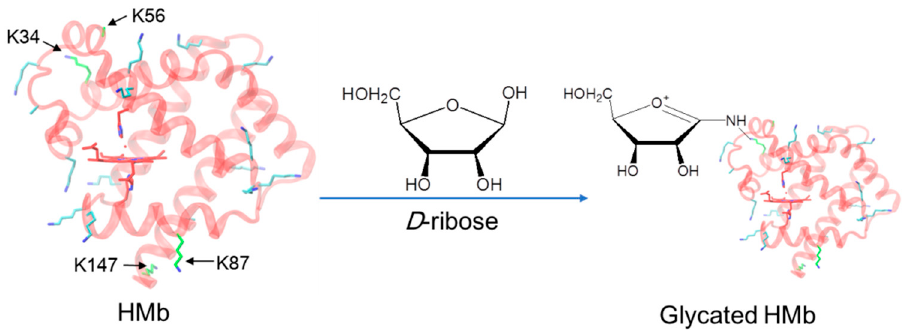
Figure 1. The X-ray crystal structure of the K45R/C110A HMb mutant ( left , PDB code 3RGK) [30]. The heme active site and the location of the Lys residues are shown for clarification. Note that the conformation of the side chain of K56 was too flexible to be determined. The protein glycation of the HMb by D -ribose is indicated by the arrow ( right ).